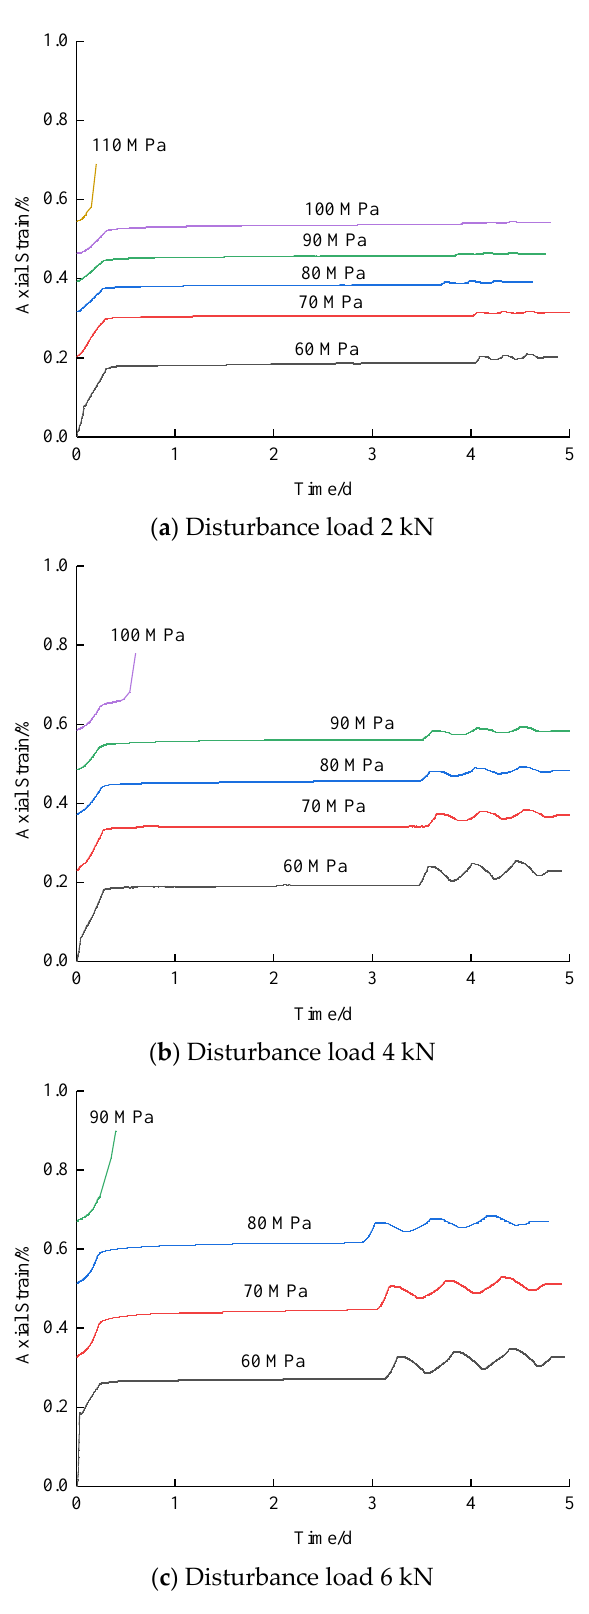
Figure 5. Axial creep curves of specimens under different disturbance loads. Figure 5 shows that only when the stress level applied to the rock is high do the stable creep and accelerated creep stages appear. Otherwise, the creep deformation only